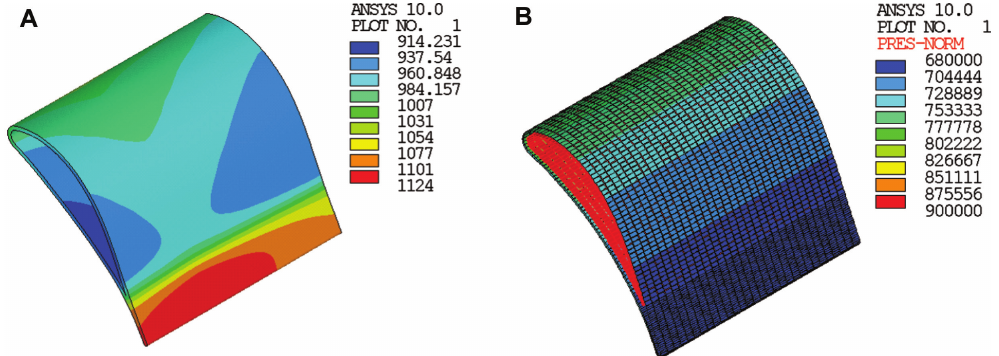
Figure 3 Temperature and pressure boundary condition.